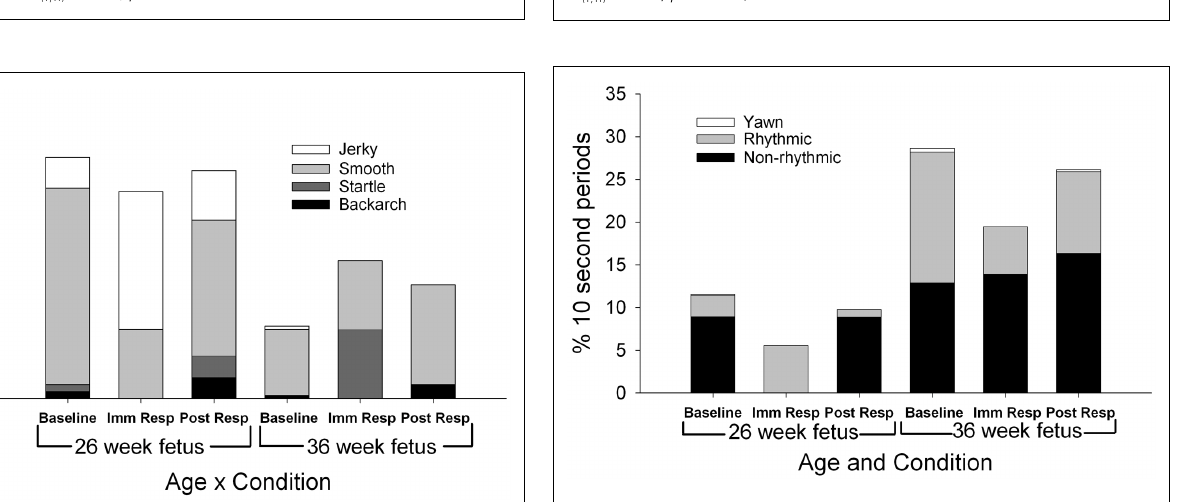
FIGURE 2 | Each column represents the average percentage of 10-s epochs for breathing movements (regular, irregular, and vigorous) and hiccups observed at 26 (columns 1–3) and 36weeks gestation (columns 4–6). For illustration, regular fetal breathing movements (white) demonstrated an interaction with a decrease in movements during the immediate response period at the 36week assessment with no difference between baseline and immediate response observed at the 26week assessment ( F (1,11) = 4.46, p = 0.027).